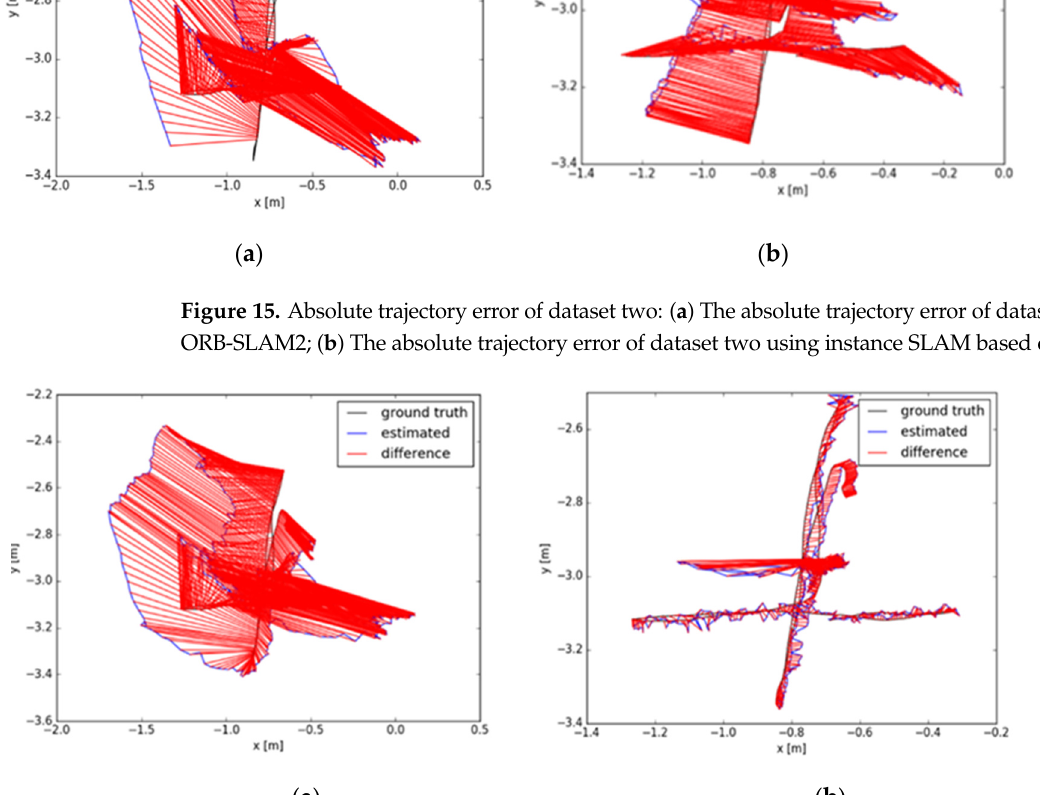
Figure 16. Absolute trajectory error of dataset three: ( a ) The absolute trajectory error of dataset two using ORB-SLAM2; ( b ) The absolute trajectory error of dataset two using instance SLAM based on CO-HDC.